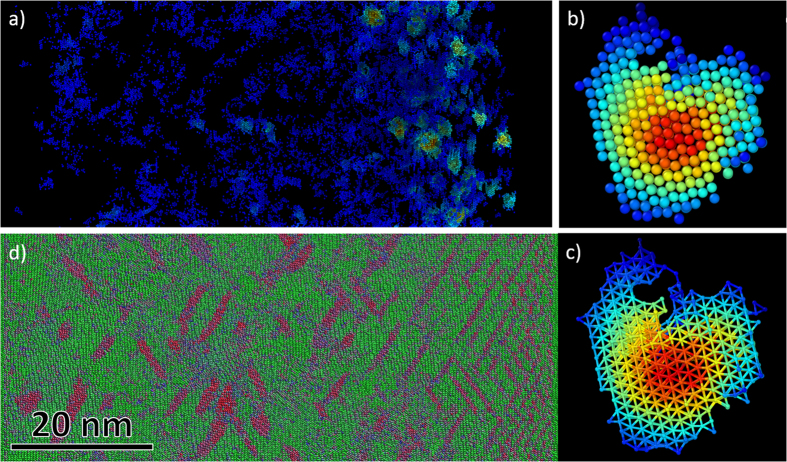
Molecular dynamics simulation of shocked [110] tantalum crystal at a particle velocity of 1.1 km/s (shock pressure near 120 GPa).(a) Hexagonal phase as filtered by adaptive common neighbor analysis25 and colored by neighbor count. Close-up images of a hexagonal cluster consisting of nearly 500 atoms showing (b) packing and (c) bonding (imaging by Ovito35). (d) Orientation imaging map where green corresponds to the <110> direction and red to the <100> direction (imaging through MD_render36 implemented in SPaSM37).